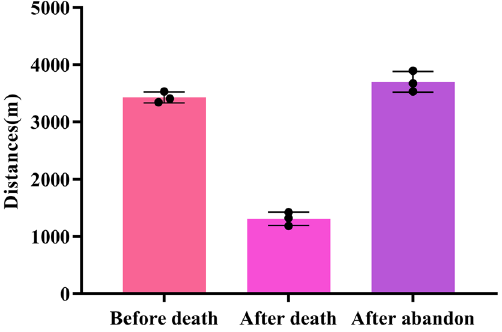
Figure 2. The average distances covered by the group and mother before, the juvenile’s death, after death, and after corpse abandonment by the